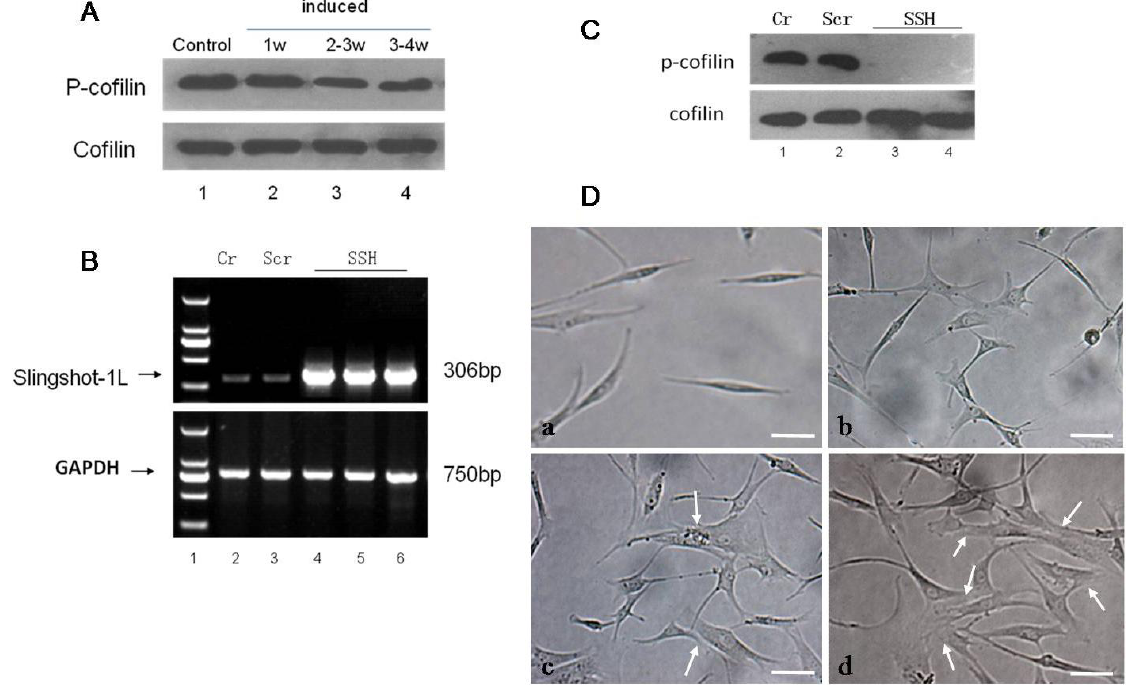
Figure 7. The effect of SSH1L on the morphology of cardiomyocyte-like cells differentiation of hMSCs. ( A ) We induced cardiomyocyte-like cells differentiation of hMSCs after the optimal concentration of 5-Aza treatment for 1 week, 2–3 week, 3–4 week, and then tested that the expression of endogenous protein phosphor-cofilin decreased with the induction time increasing; ( B ) The hMSCs were transfected with the retroviral vector pLNCX-SSH1L to overexpress SSH, and the empty vector transfected group (Scr) and an untransfected group (Cr) were compared as controls. In addition, the expression of SSH1L was observed; ( C ) Compared to Cr and Scr, the endogenous protein expression of phosphor-cofilin decreased apparently in the SSH group of transfected hMSCs (SSH1L), and there are no difference between Cr and Scr; ( D ) The effect of SSH1L on the morphological changes of cardiomyocyte-like cells induced by 5-Aza were photographed under a microscope . Arrows indicate the myotube-like structures. Scale bar, 20